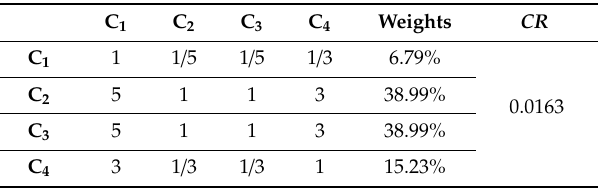
Table 7. Linguistic scale and corresponding